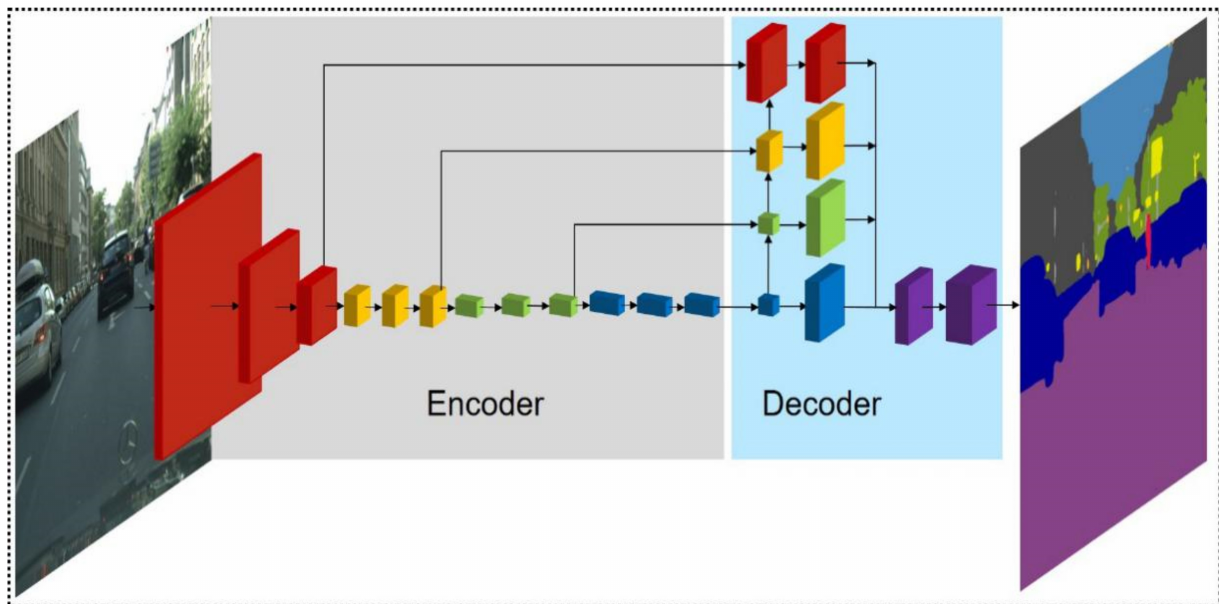
Figure 2. The architecture of Hierarchical Feature Extraction Network (HFEN). The size of each block represents the size of corresponding feature maps. While different colors show blocks at different stages in the encoder and their aggregated feature in the